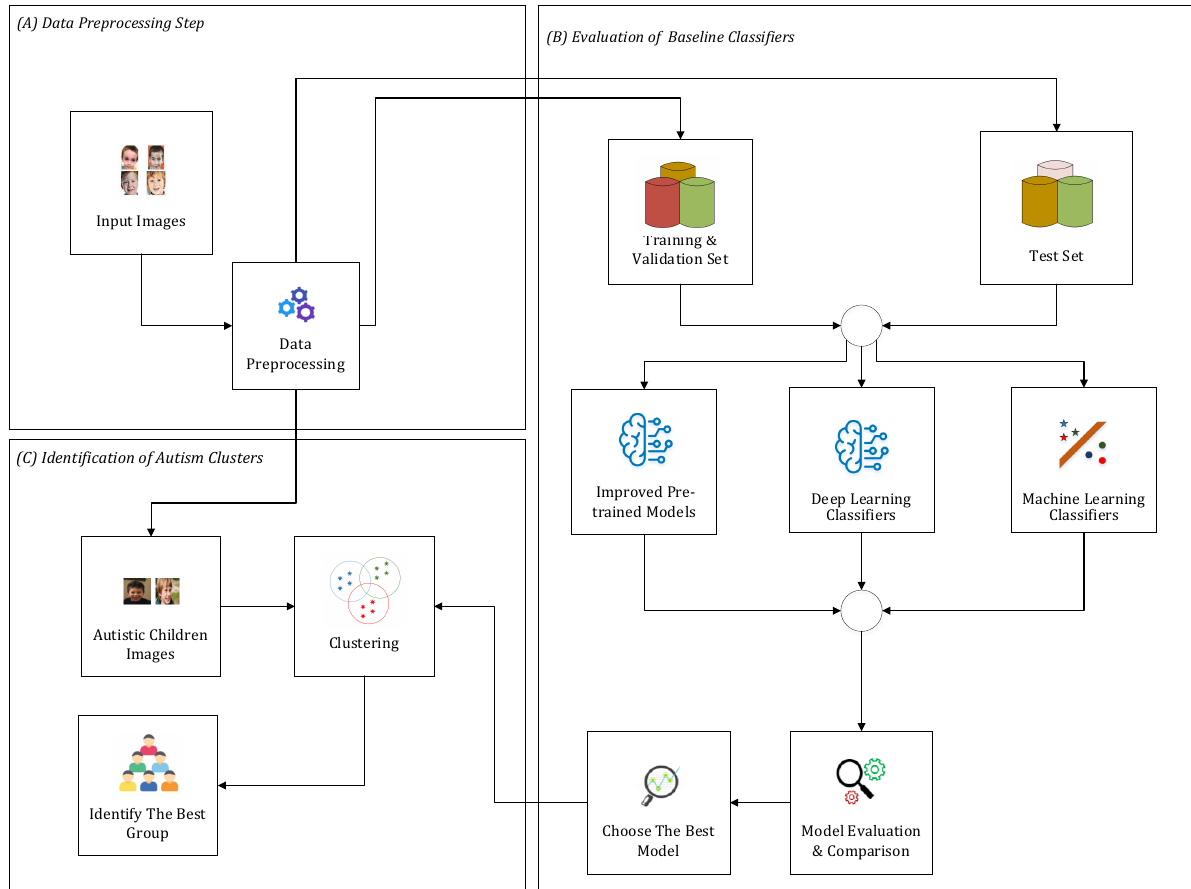
Figure 1. The schematic diagram of our proposed transfer-learning-based facial recognition framework. ( A ) Data pre- processing step: organization of raw images for further activities; ( B ) Evaluation of Baseline Classifiers: performance analysis of improved models with state-of-the-art classifiers; ( C ) Identification of autism clusters: investigate individual clustering groups and explore the best group using machine learning